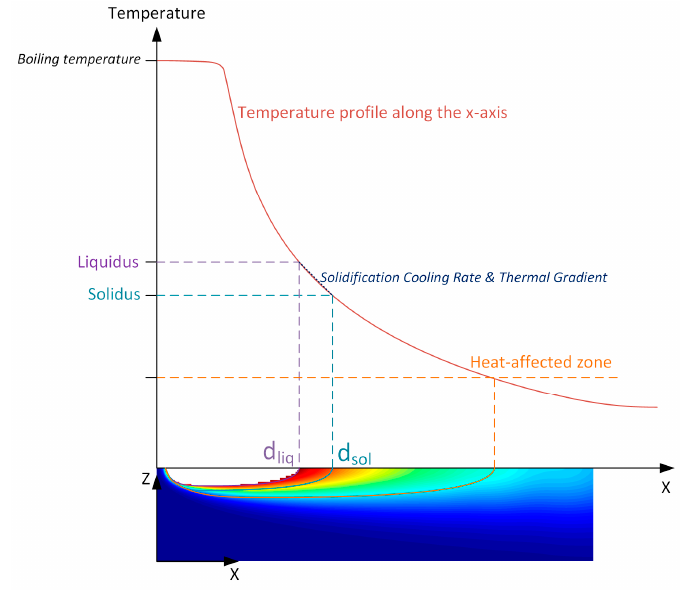
Figure 1. Schematized temperature profile along meltpool centerline.